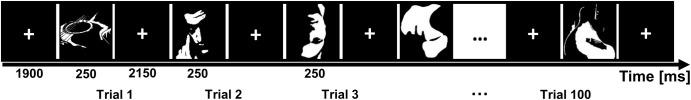
Task timeline: Mooney stimuli (ambiguous black and white shapes) of faces/inverted faces, guitars and scrambled pictures were presented for 250ms.Subjects had to detect a face (or not) and respond (button press) during the inter-stimulus interval (1900-2150ms). Stimulus order was randomized and the experiment was divided in three runs (100 trials per run) to avoid subject fatigue.